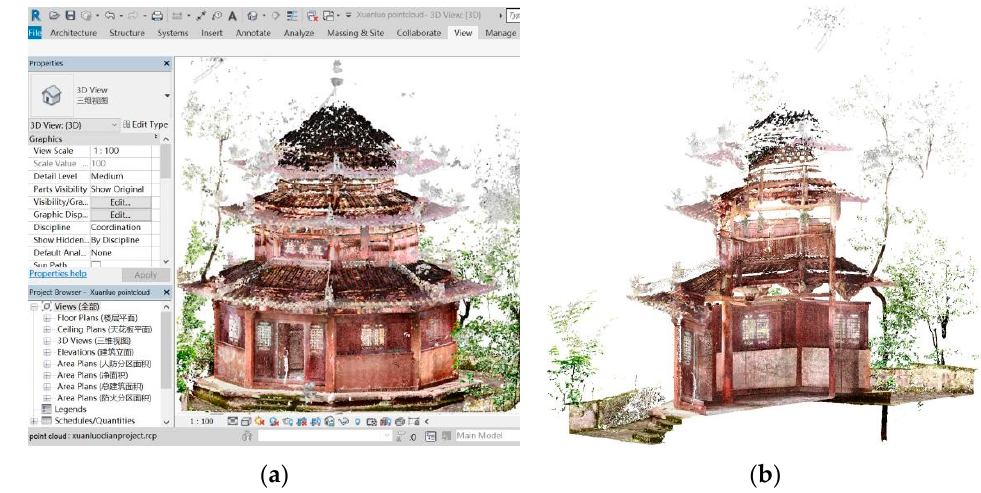
Figure 15. Point cloud in BIM: ( a ) Point cloud in Revit; ( b ) View with the profile box.